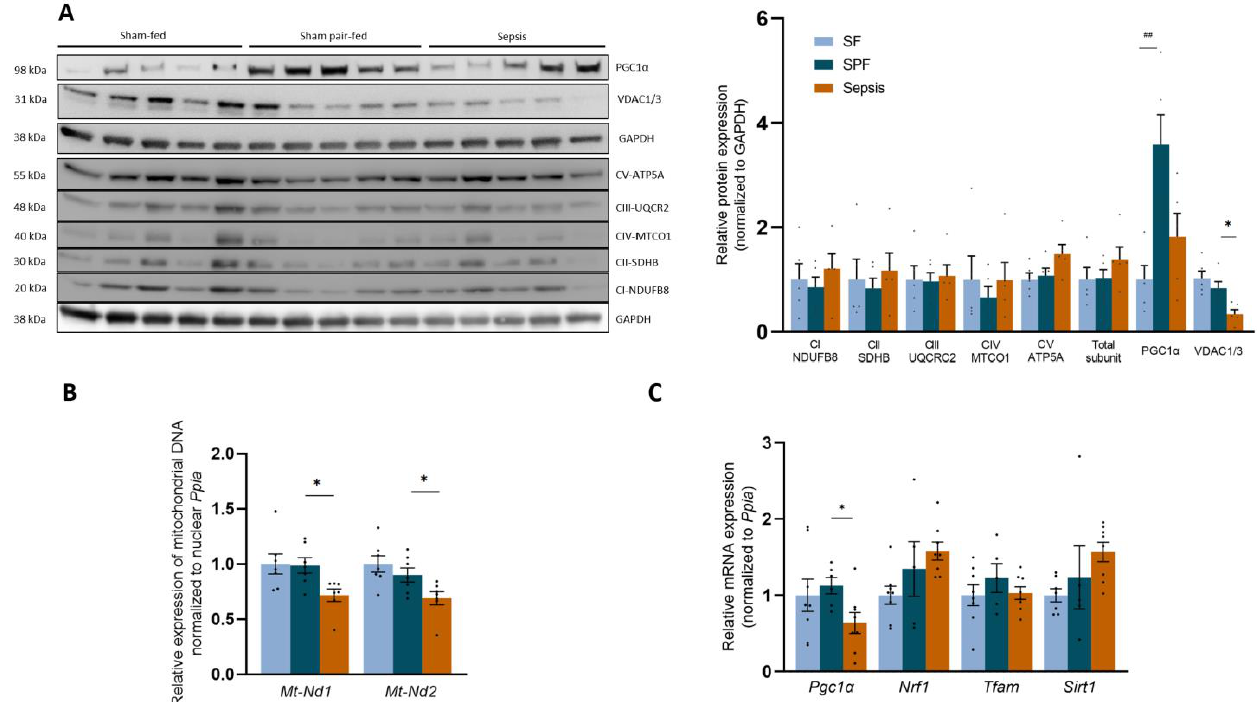
Figure 5. Sepsis-like energy deficit induced specific biogenesis adaptations in skeletal muscle not observed in sepsis. ( A ) Protein expression of different subunits of the respiratory chain complexes was not significantly different between groups. VDAC was lower in the Sepsis group than in the Sham pair-fed (SPF) group. Total PGC1α protein expression was higher in the SPF group than in the Sham-fed (SF) group and remained unchanged in the Sepsis group compared with the SPF group. ( B ) Mitochondrial DNA expression of Nd1 and Nd2 normalized to nuclear Ppia decreased in the Sepsis group compared with the SPF group. ( C ) mRNA expression of the biogenesis actors Nrf1 , Tfam , and Sirt1 was not different between groups, but Pgc1α was lower in the Sepsis group than in the SPF group. Light-blue bars for SF mice, dark-blue bars for SPF mice, and orange bars for Sepsis mice (n = 5–8 per group). Data expressed as means with SEM and compared using a Kruskal–Wallis test with post hoc Dunn’s test. # SPF vs. SF and * Sepsis vs. SPF. * p < 0.05, ## p <